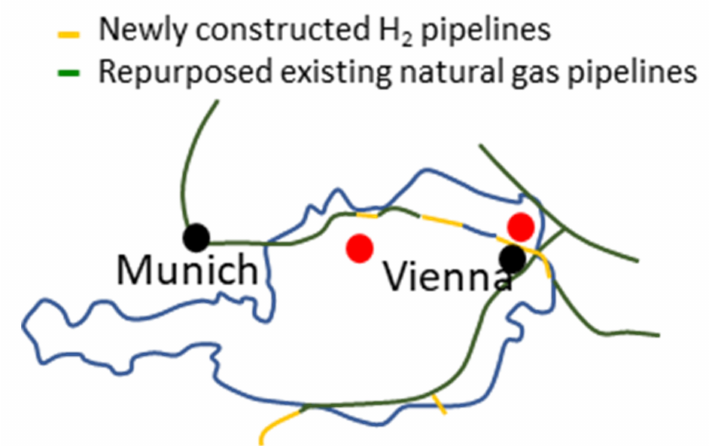
Figure 16. Oil (green) and gas (red) fields in Austria (© GBA/Geo-Atlas Österreich).